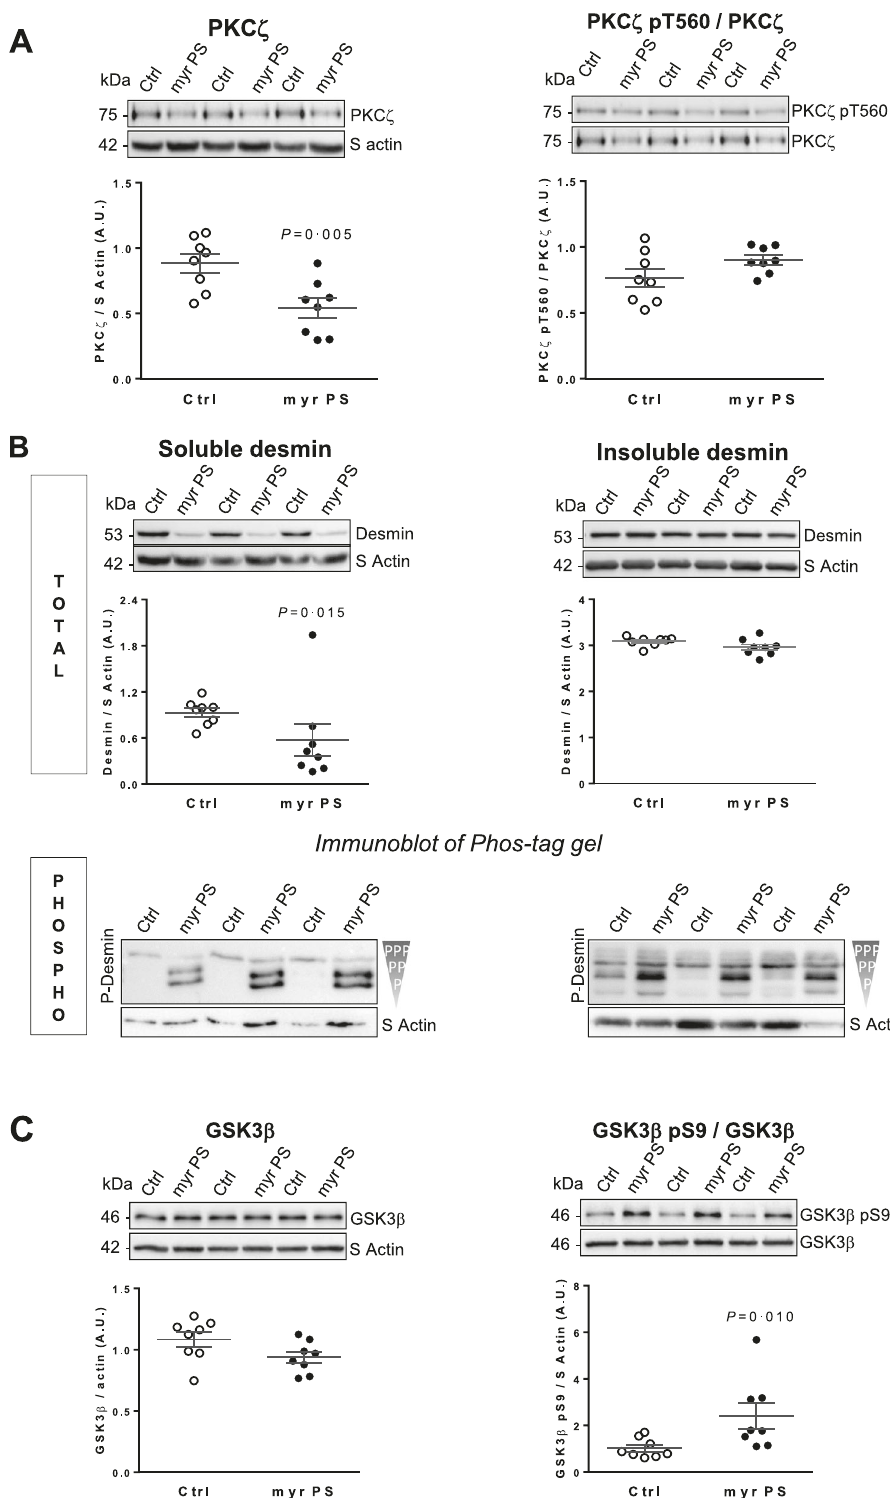
Fig. 3 PKC ζ modulates desmin phosphorylation in vitro in cardiomyocytes. A Representative western blots and quanti fi cation of PKC ζ levels (left panel) and active PKC ζ (PKC ζ pT560/PKC ζ ratio) (right panel) in control and NCM treated with 10 µmol/L of PKC ζ inhibitor, myrPS for 1 h ( n = 8). B Soluble (top left panel) and insoluble (top right panel) desmin levels and their phosphorylation pro fi les (Phos-tag gel, bottom panels) were analyzed in response to PKC ζ inhibition in the same samples. Each band of the desmin immunoblot of Phos-tag gels represents a phosphorylated form of desmin, the upper band being the most phosphorylated and the lower band the less or no phosphorylated form of desmin. C Representative western blots and quanti fi cation of GSK3 β levels (left panel) and inactive GSK3 β (GSK3 β pS9/GSK3 β ratio) (right panel) in the same samples. The loading control (S Actin) is indicated on the graphs. Graphs show individual and mean ± SEM values expressed in arbitrary units (A.U.). Signi fi cant P values are indicated on the